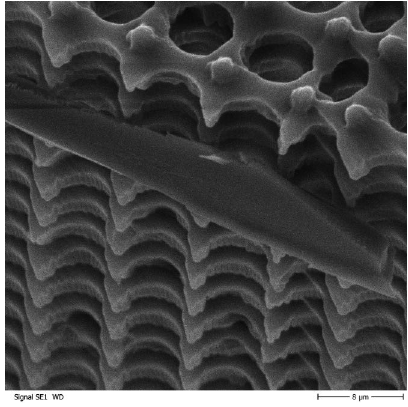
Figure 11. Structure with 35x35x35 microcells closeup (0.28mm side length)